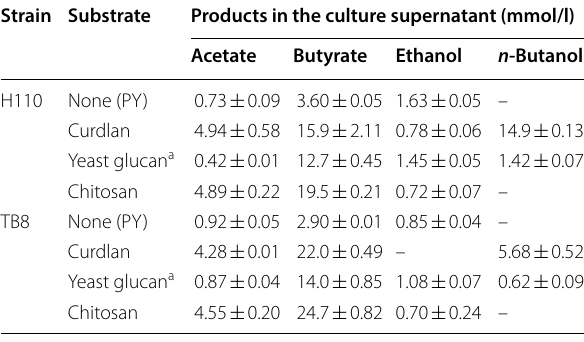
Table 1 Products in the culture supernatants used for determination of enzymatic activities for strains H110 and TB8